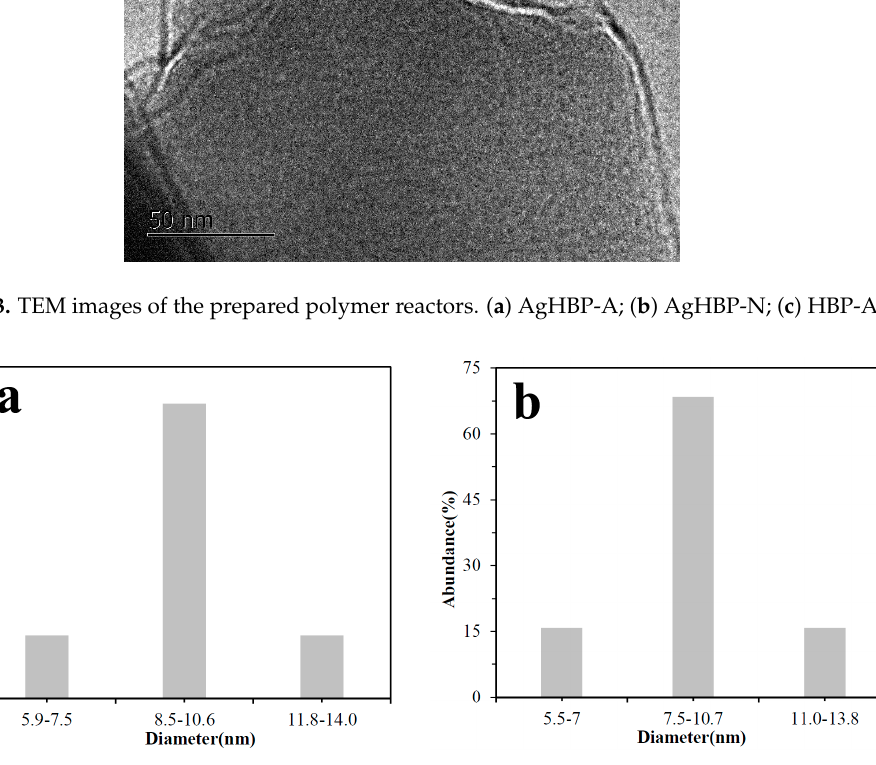
Figure 4. Particle distribution of AgHBP-A ( a ) and AgHBP-N ( b ).